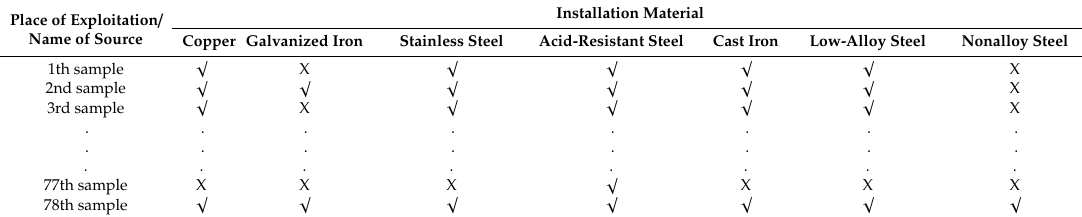
Table 3. Values for indices at which corrosion of individual installation materials will not occur—a snapshot of all the waters